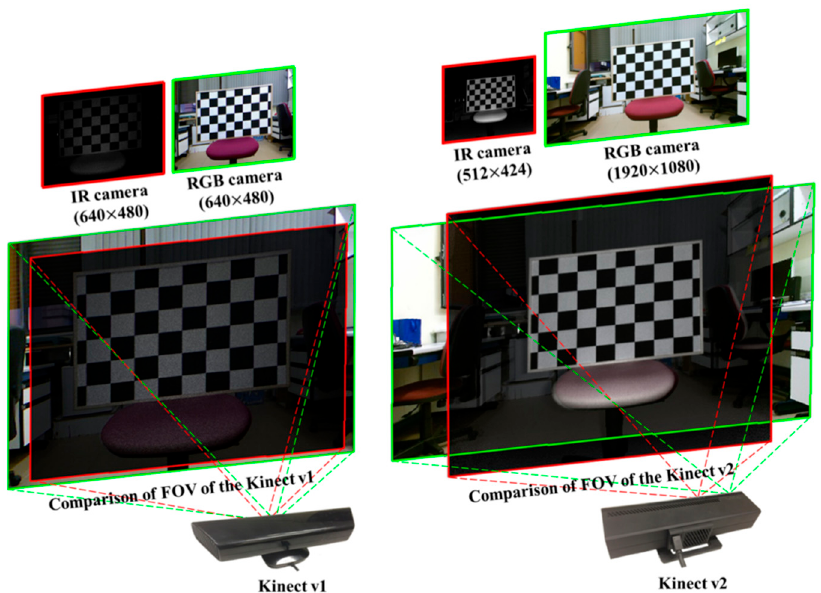
Figure 9. Kinect v1 and v2 overlap regions in the captured scene. The green rectangle represents the RGB view, and the red rectangle represents the IR view [47]. Sensors 2019 , 19 , x FOR PEER REVIEW